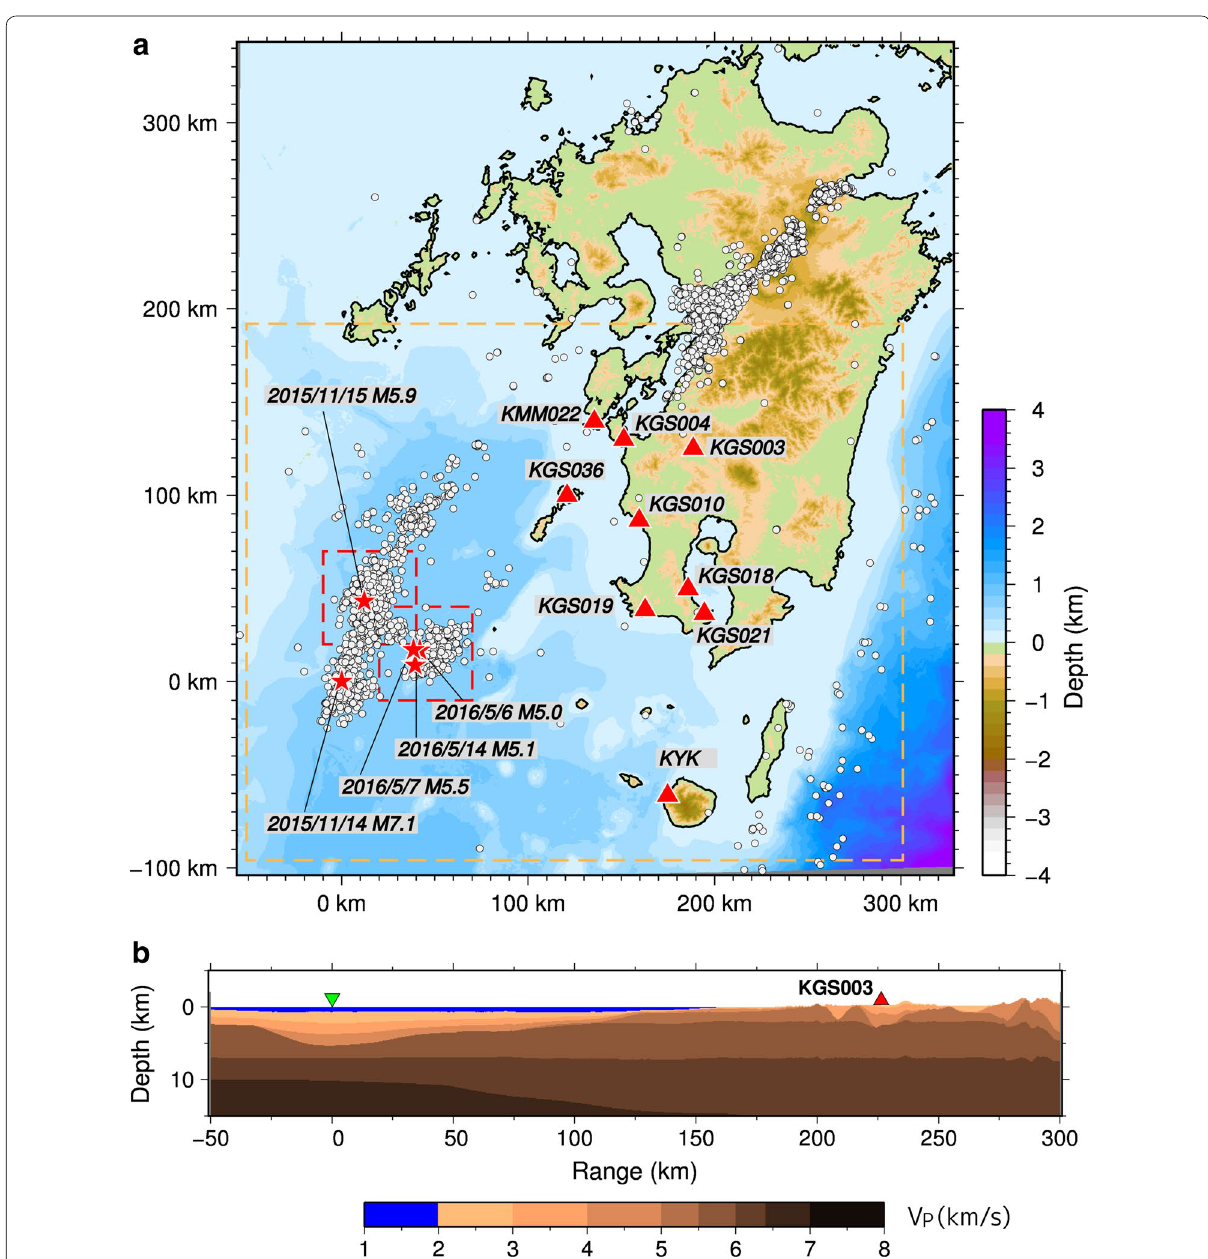
Fig. 3 a Detailed map of the studied area. The epicenters of earthquakes from 11/14/2015 to 06/30/2016 (JST) with M JMA are shown with white circles . The epicenters of the events analyzed in this study are shown with red stars , eight K-NET and one F-net (KYK) stations are shown as red triangles , and the outer rectangle with an orange broken border indicates the FDM region. Rectangles with red broken borders denote the horizontal area of the grid search for the source location. b Vertical slice of the P-wave velocity structure through the epicenter of EV1 and sta- tion